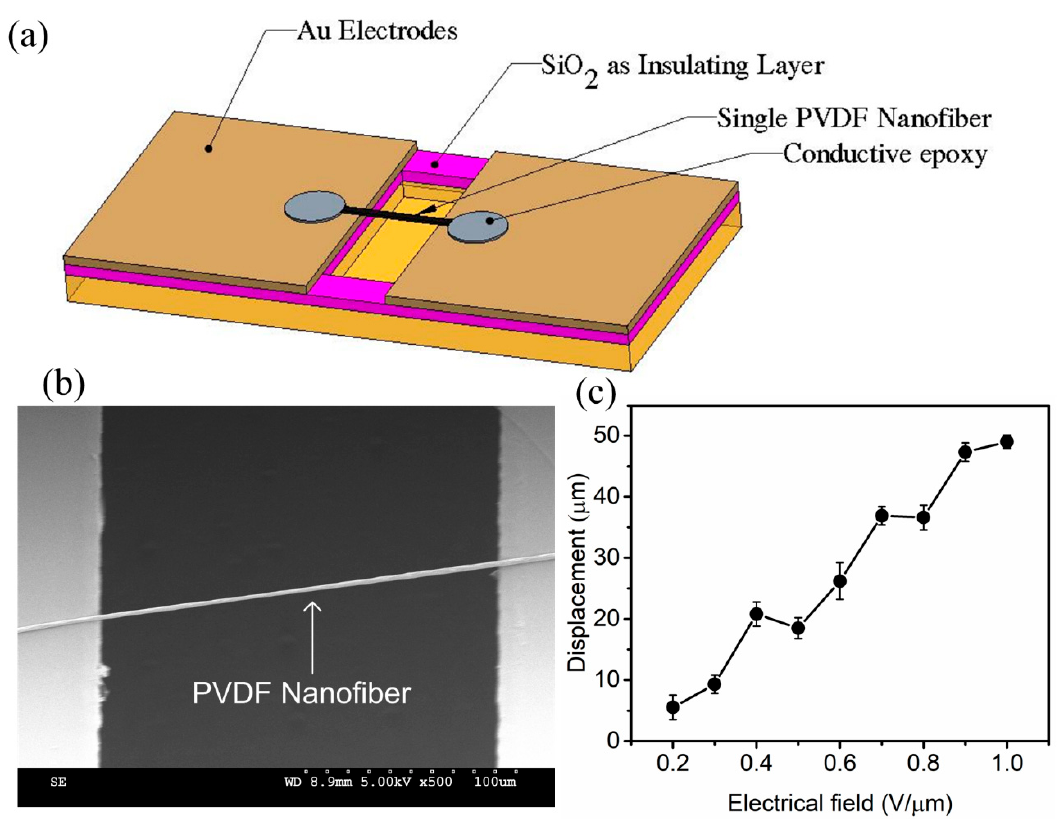
Figure 4. ( a ) Fabricated substrate; ( b ) schematic diagram of the device for measuring the piezoelectric coefficient of a single nanofiber. Insert shows a suspended PVDF nanofiber with a diameter of 800